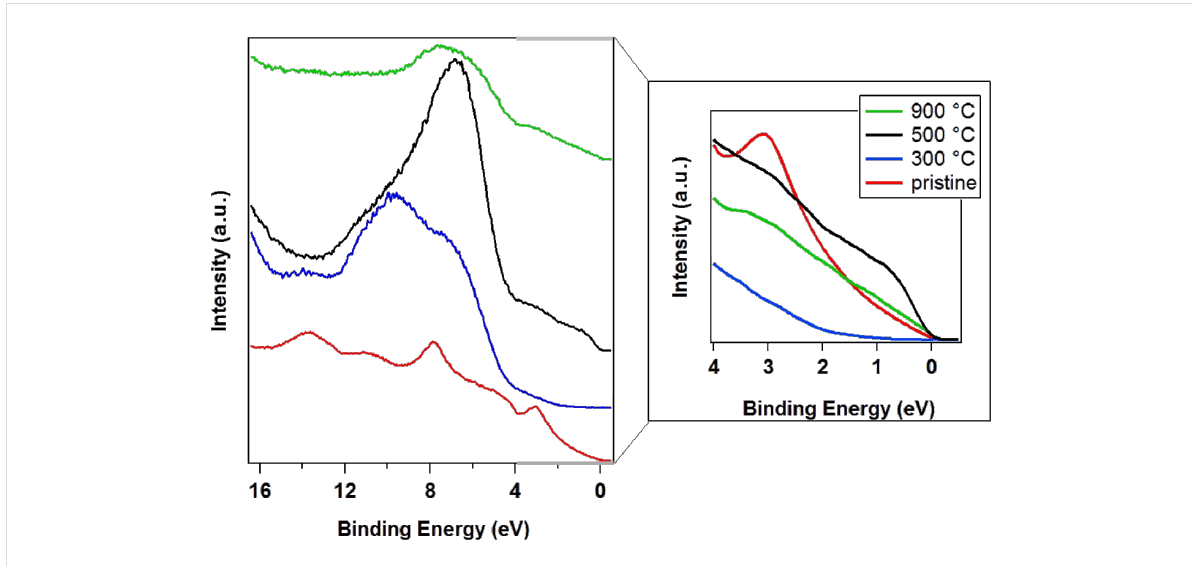
Figure 3: UPS spectra acquired with a photon energy of h ν = 31 eV, the red line is the pristine vCNT sample, the blue is the functionalized, annealed ( T = 300 °C) sample, the black and the green lines are related to samples heated at 500 and 900 °C, respectively.